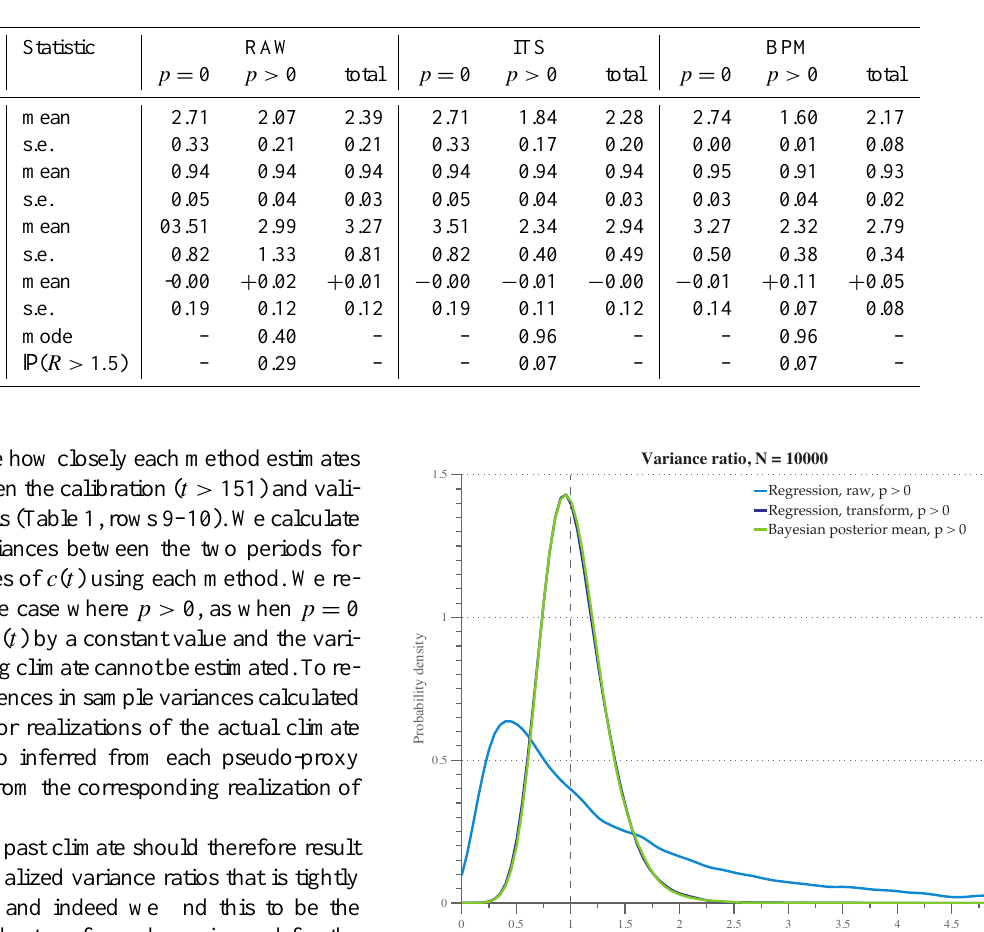
Table 1. Inference diagnostics derived from 10000 realizations of the climate process c ( t ), for each of the three inference approaches, with δ = 0 . 5. CI width is the width of the 95% uncertainty intervals produced by each method (see Fig. 5) averaged over the 300 time points. The coverage rate should be compared to its nominal value of 95%. The interval score should be as small as possible. The bias is defined as the difference between the estimated and true climate, averaged over the entire interval. All statistics have been stratified according the sign of p to account for the varying amounts of uncertainty in each case. For the top three rows, we report the mean and standard error (s.e.) of each distribution, obtained from the 10000 realizations. The variance ratio statistics pertain to the distributions plotted in Fig. 6; variance ratios for p = 0 are not reported because all methods produce constant estimates in that case.